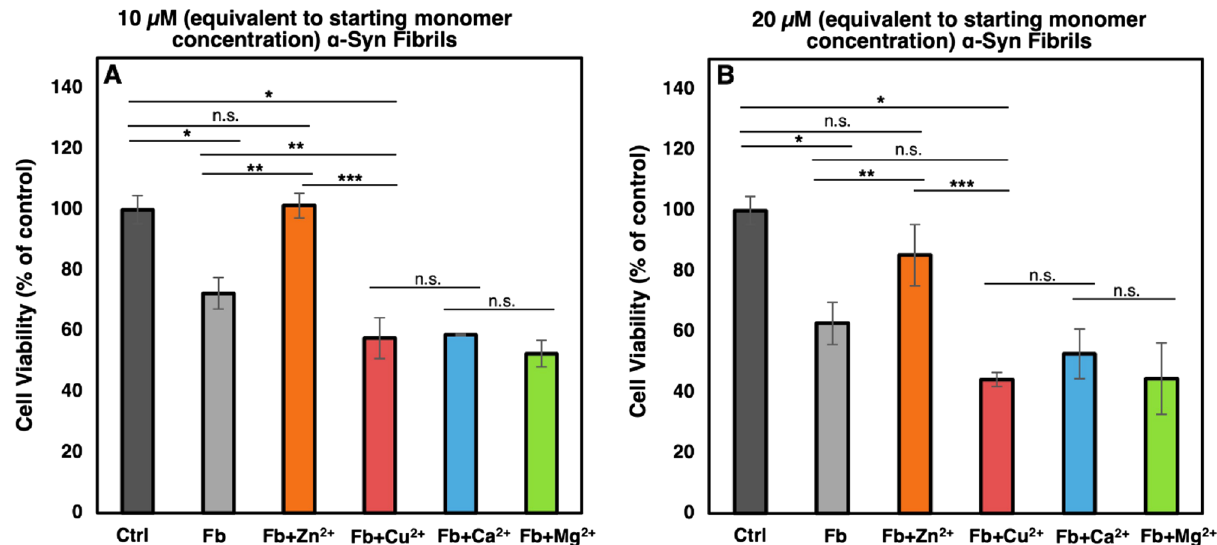
Figure 6. Cytotoxicity of fibrils formed in the presence and absence of each metal ion. SH-SY5Y cells were treated with α-Syn fibrils formed in Tris or in presence of the metal ions. The end stage fibrils were separated by centrifugation and after correction for concentration were used in cytotoxicity studies. The cells were treated by ( A ) 10 µM and ( B ) 20 µM of fibrils (corresponding to the starting monomer concentration). Cell viability was determined based on ability of cells to metabolize MTT. Fb: α-Syn fibrils. * p < 0.05 significant difference compared to the control group. ** p < 0.05 significant difference compared to the Fb group. *** p < 0.05 significant difference compared to the Fb + Zn 2+ group. “n.s.” denotes “not significant”